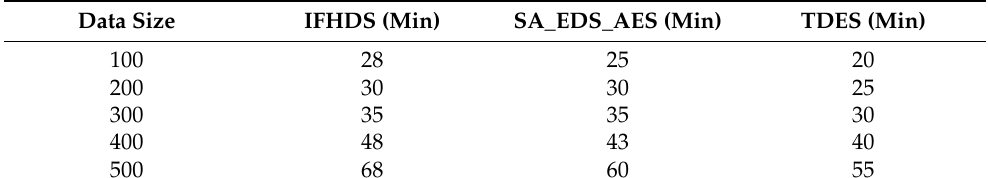
Table 4. TDES methodology is compared with existing techniques in terms of execution time.